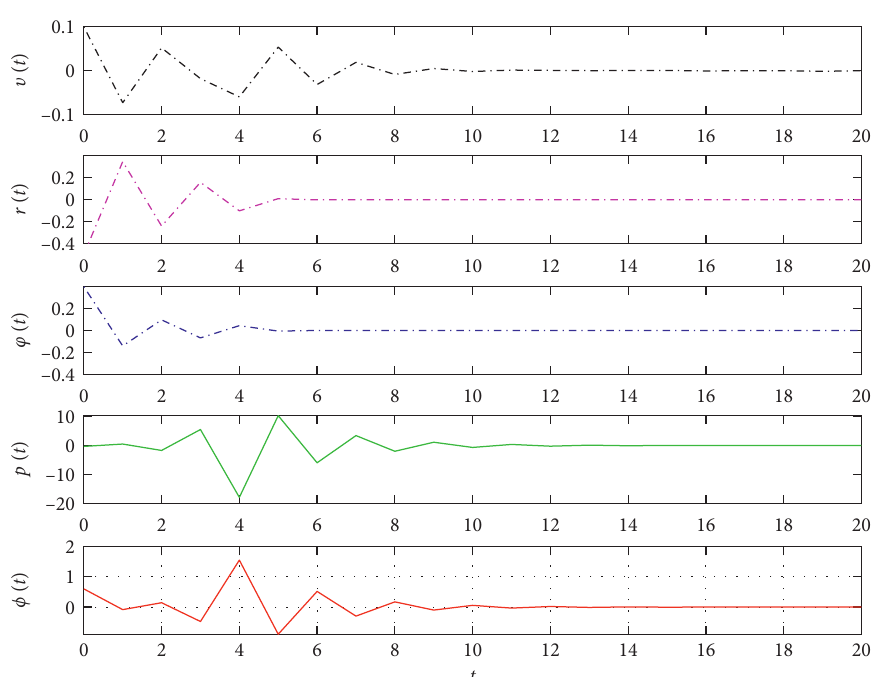
Figure 8: The state response of closed-loop of NSUSVs (25) by using our